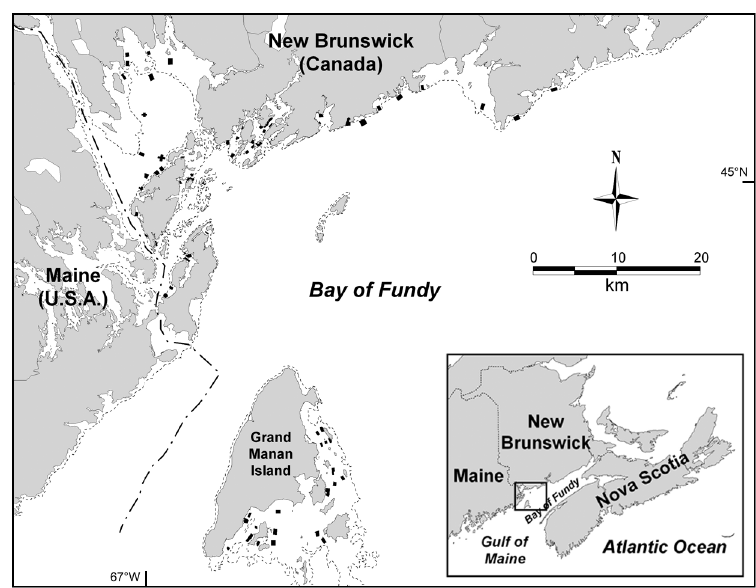
Fig. 1. Map of southwestern New Brunswick (SWNB) showing locations of the 70 salmon farms included in the model. The dashed line along shore indicates the 20 m depth